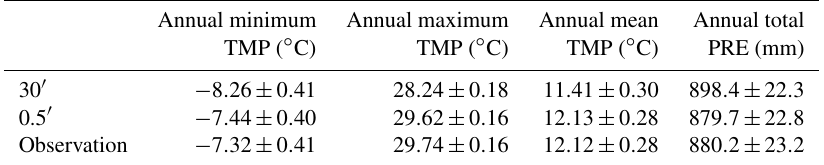
Table 4. Comparison of the averaged climatology among the independent weather stations during 1951–2016, based on the 30 (cid:48) original datasets, the 0.5 (cid:48) datasets downscaled with the bilinear interpolation, and the